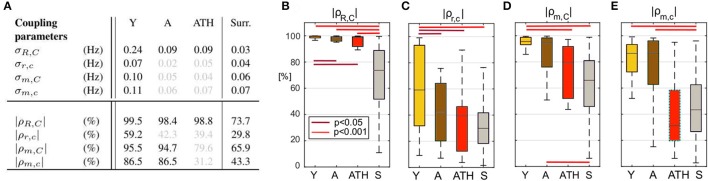
Statistics for coupling parameters. (A) Table showing the median values for the coupling strength σ and modulus of similarity |ρ| for groups of Y, A, ATH subjects, and surrogates, with median values not significantly different from surrogates are shown in gray. Box-plots picturing the distributions of the similarity modulus |ρ| within each group, using the same color map as Figure 4. The relation between respiration and cardiac for the (B) central and (C) peripheral networks and of myogenic and cardiac for the (D) central and (E) peripheral networks.